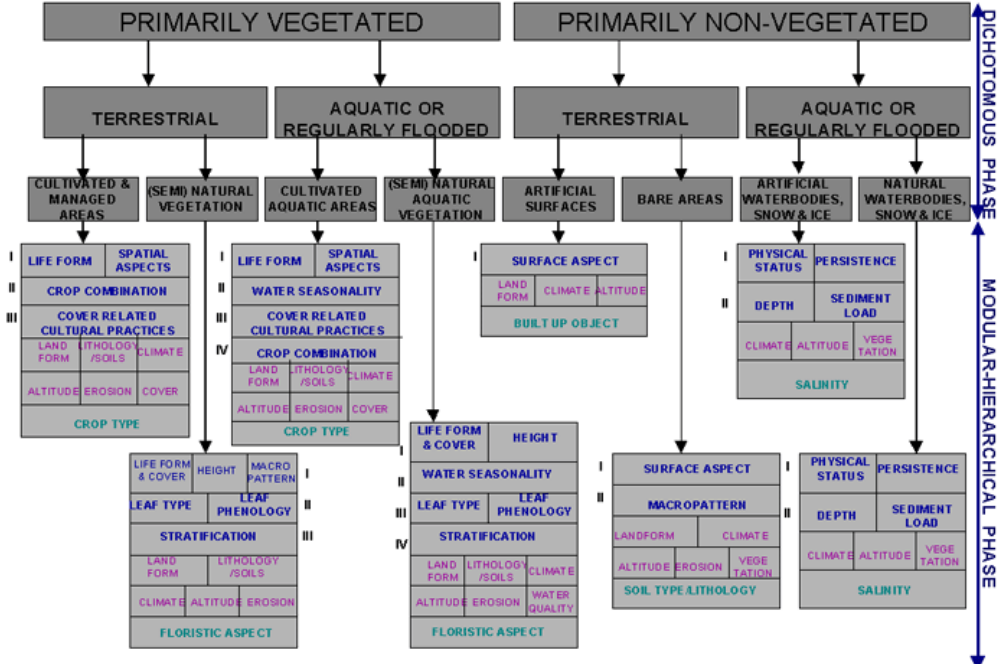
Figure 1. As in [16], courtesy of the Food and Agriculture Organization (FAO of the United Nations (UN). Two-stage fully-nested FAO Land Cover Classification System (LCCS) taxonomy. The first-stage fully-nested 3-level 8-class FAO LCCS Dichotomous Phase (DP) taxonomy is general-purpose, user- and application-independent. It consists of a sorted set of three dichotomous layers: (i) vegetation versus non-vegetation, (ii) terrestrial versus aquatic, and (iii) managed versus natural or semi-natural. These three dichotomous layers deliver as output the following 8-class FAO LCCS-DP taxonomy. (A11) Cultivated and Managed Terrestrial (non-aquatic) Vegetated Areas. (A12) Natural and Semi-Natural Terrestrial Vegetation. (A23) Cultivated Aquatic or Regularly Flooded Vegetated Areas. (A24) Natural and Semi-Natural Aquatic or Regularly Flooded Vegetation. (B35) Artificial Surfaces and Associated Areas. (B36) Bare Areas. (B47) Artificial Waterbodies, Snow and Ice. (B48) Natural Waterbodies, Snow and Ice. The general-purpose user- and application-independent 3-level 8-class FAO LCCS-DP taxonomy is preliminary to a second-stage FAO LCCS Modular Hierarchical Phase (MHP) taxonomy, consisting of a battery of user- and application-specific one-class classifiers, equivalent to one-class grammars (syntactic classifiers) [19] .